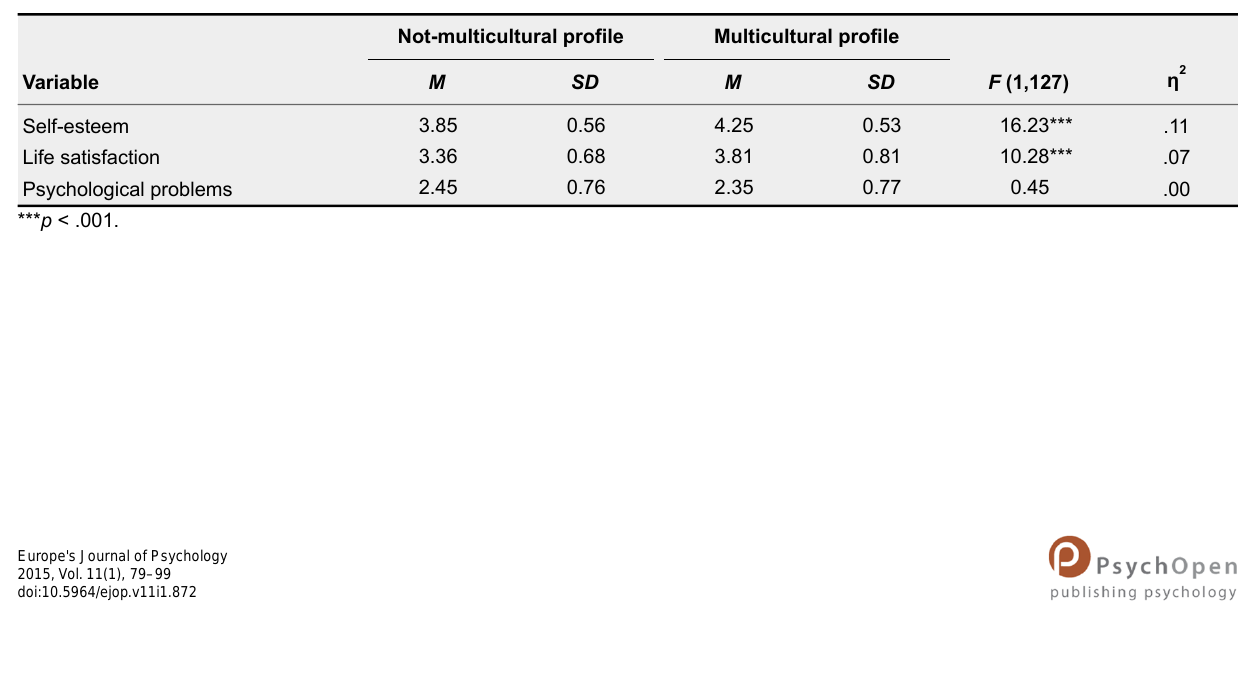
Means and Standard Deviations of Italian Adolescents’ Adaptation